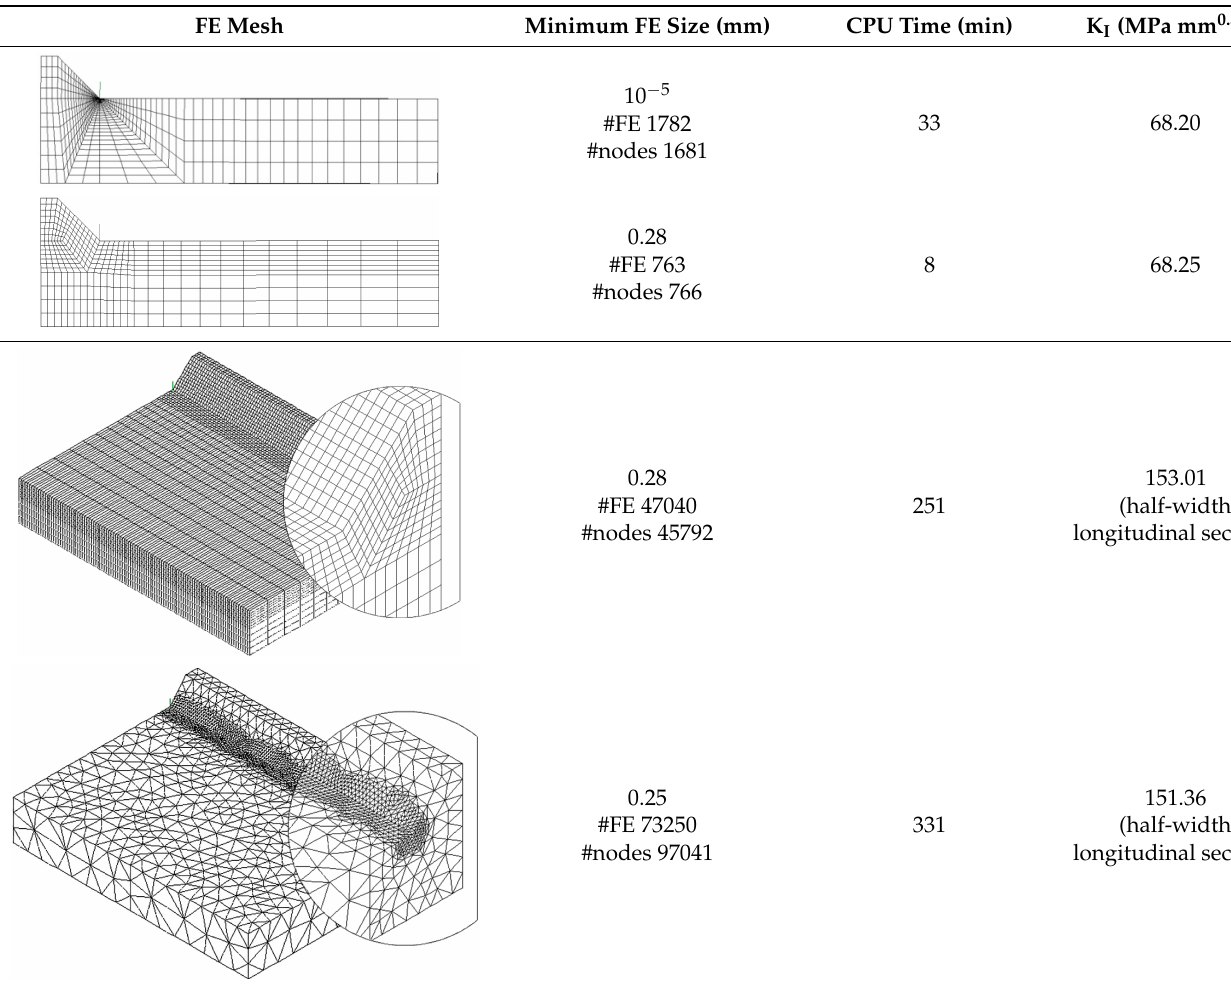
Table 2. Residual Notch Stress Intensity Factor (R-NSIF) values obtained by means of 2D and 3D FE models. The table includes also the central processing unit (CPU) time for each